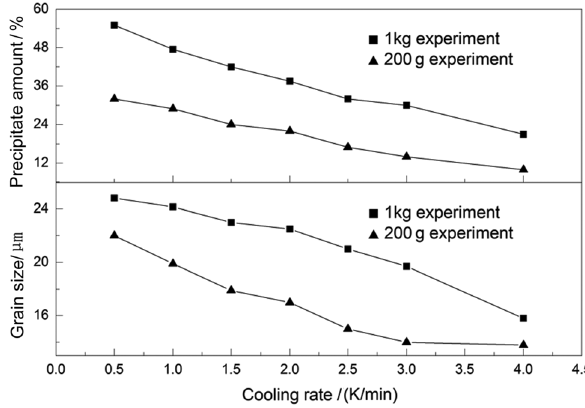
Figure 12: Precipitate amount and average grain size of rutile with different cooling rates.